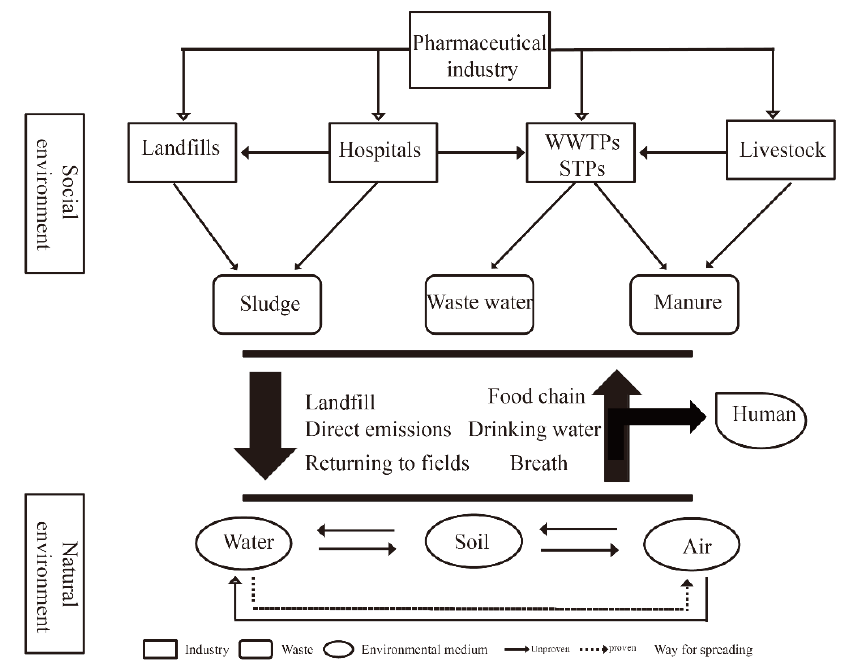
Figure 2. Main transport routes of TCs in the environment.